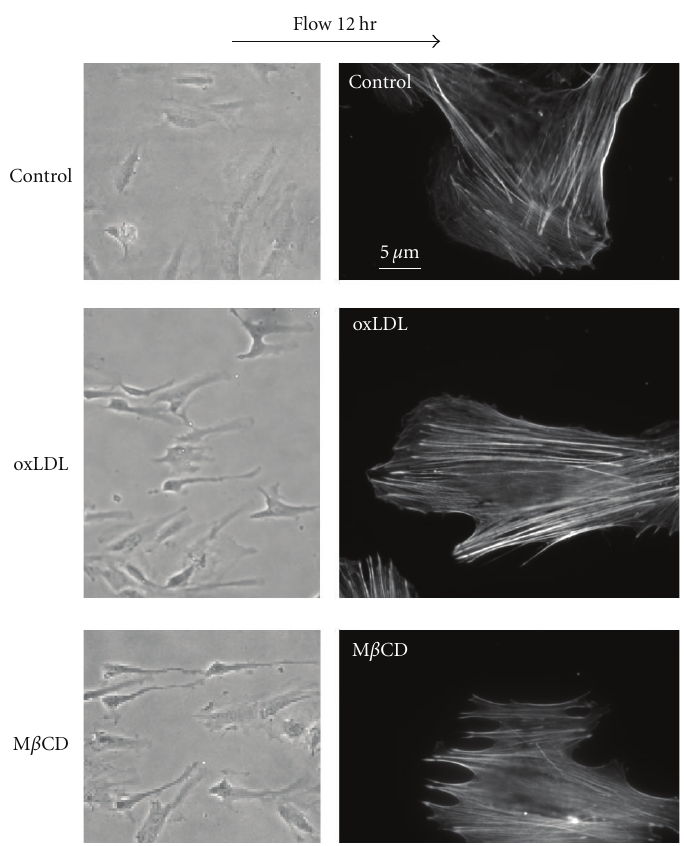
Figure 4: oxLDL and cholesterol depletion have similar e ff ects on realignment of endothelial cells in the direction of the flow. Left column: typical images of control, oxLDL-treated cells (10 μ g/mL oxLDL, 1h), and M β CD-treated cells (5mM, 1 h) exposed to 10dyn/cm 2 for 12 hours. Right column: typical images of F-actin structure in the same cell populations. Arrow indicates the direction of flow. Adapted from